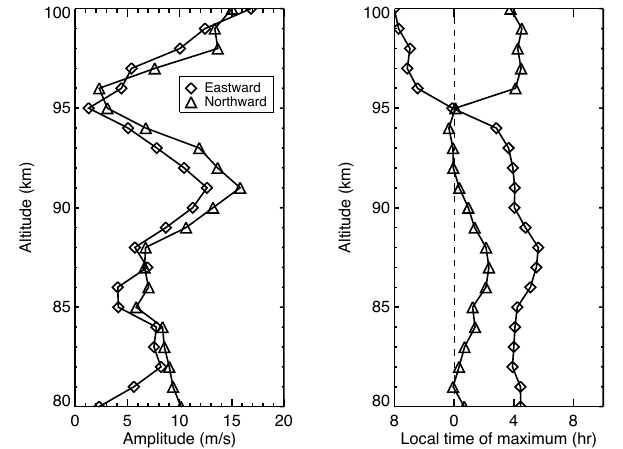
Figure 10. Altitude profiles of semidiurnal tidal amplitude (left) and local time of maximum (right). Diamonds and triangles denote eastward and northward components, respectively.